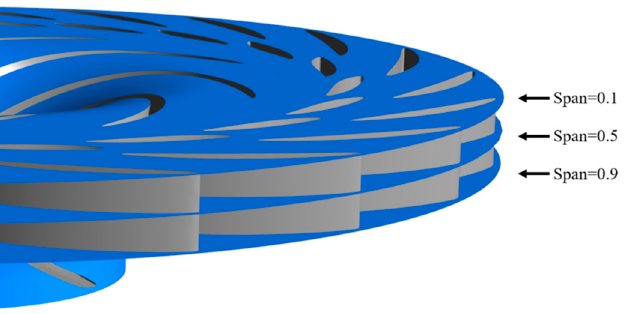
Figure 2. Spanwise position of the three selected planes through the runner, guide vane, and stay vane flow domains. Table 1. Main parameters of the prototype pump-turbine operated in pump mode.